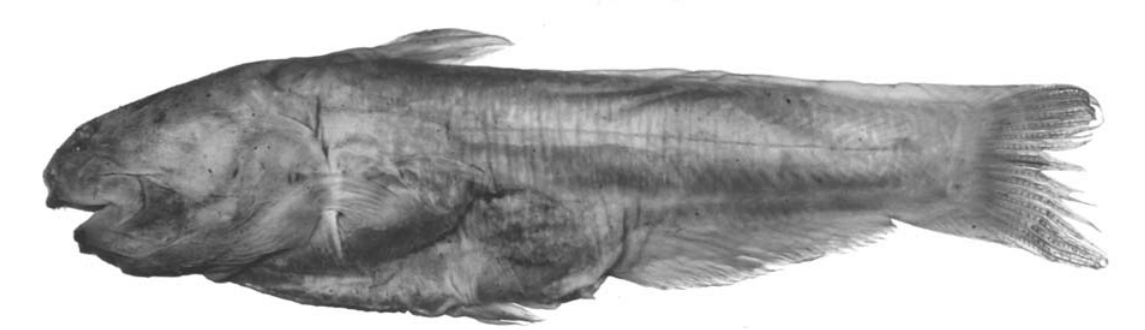
Fig. 48 . Denticetopsis macilenta, holotype of Hemicetopsis macilentus , FMNH 53260, 44 mm SL; Guyana, creek below Potaro Landing (5°23’N, 59°08’W).